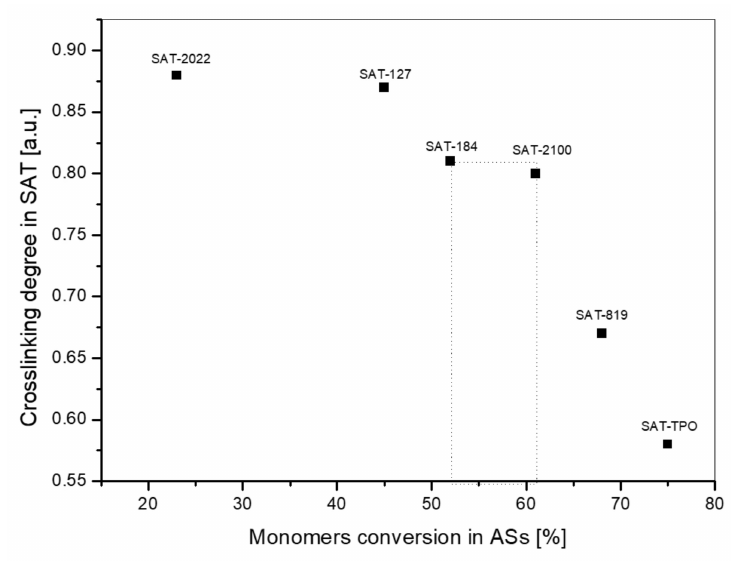
Figure 8. Influence of the monomers’ conversion of ASs (C, NMR data) on cross-linking degree (calculated using DSC data) for thermally cured SATs.